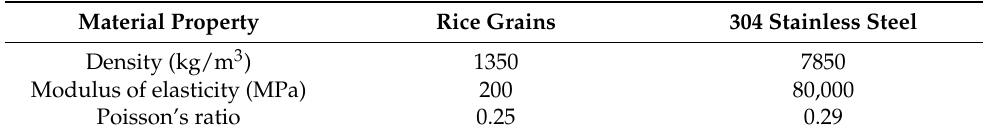
Table 2. Material parameters of collision simulation.